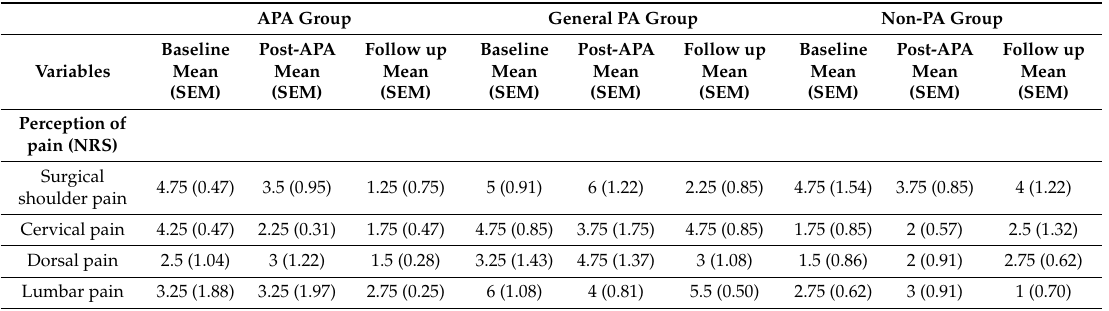
Table 4. Mean scores of pain intensity questionnaire at the baseline, post-APA, and follow up (two years post-APA) for each of the three study groups. APA